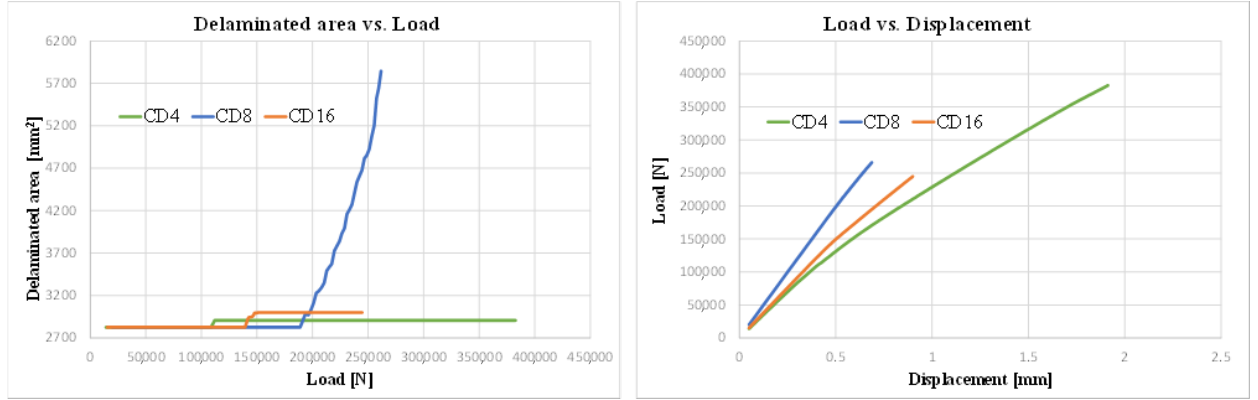
Figure 16. Delaminated area vs. load and load vs. displacement charts. Comparison against CD4, CD8 and CD16 configurations.